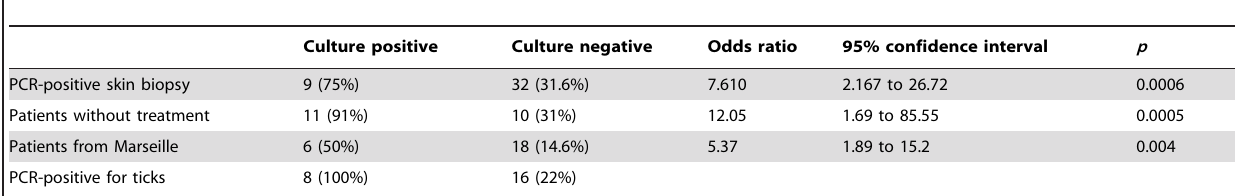
Table 4. Comparison of data between positive and negative